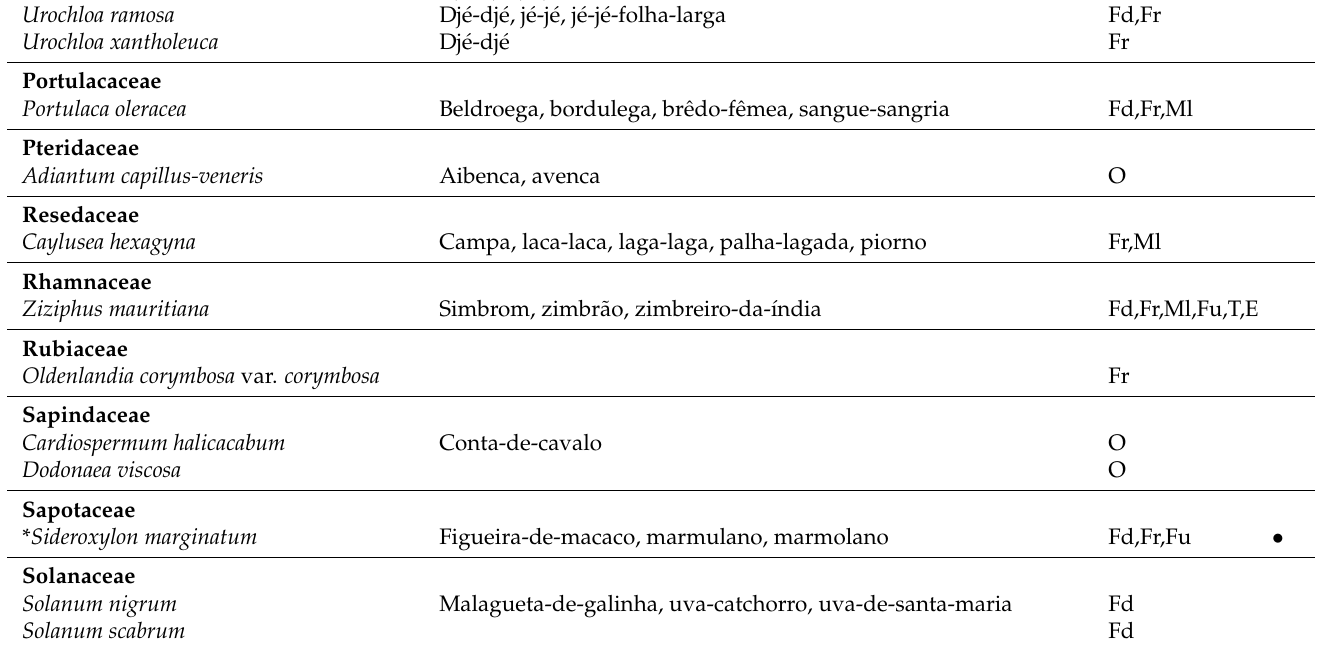
Figueira-de-macaco, marmulano, marmolano Fd,Fr,Fu